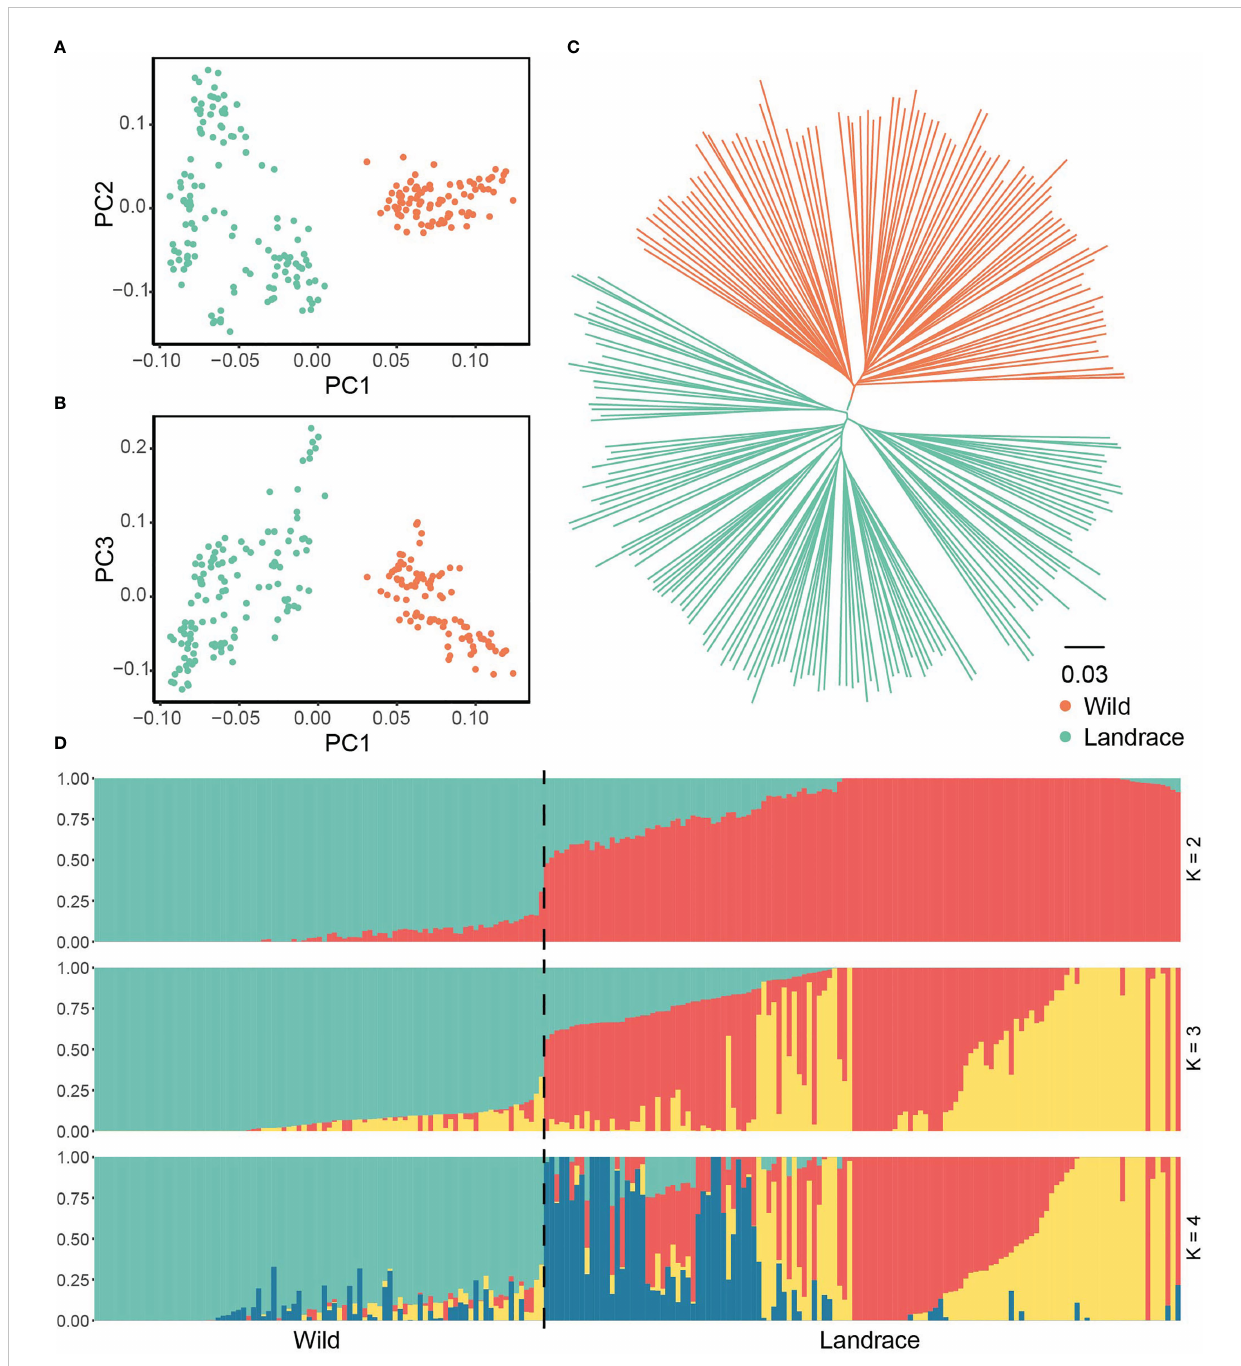
FIGURE 8 Population structure between wild barley and landrace based on SNPs in expanded genes. (A) Principal component analysis PC1 vs . PC2. (B) Principal component analysis PC1 vs . PC3. (C) The NJ phylogenetic tree. (D) Population structure with K ranging from 2 to